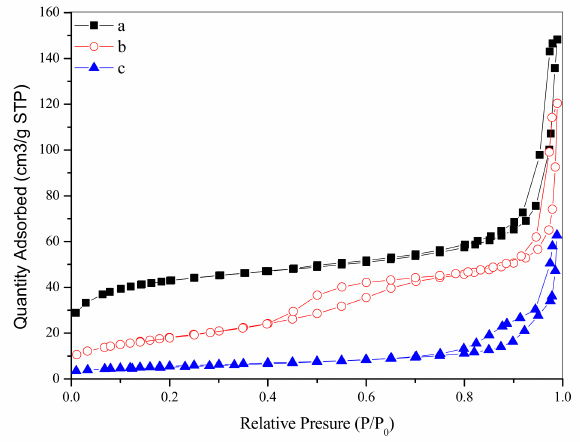
Figure 4. N 2 adsorption–desorption isotherms of as-synthesized ( a,b ) and calcined zirconia ( b ) calcined at 723 K; ( c ): calcined at 923 K.